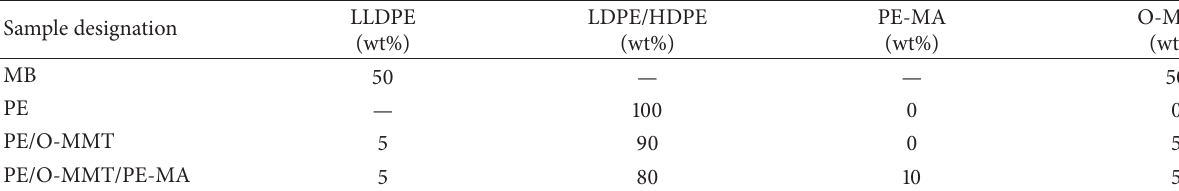
Table 1: Sample formulation and designation.